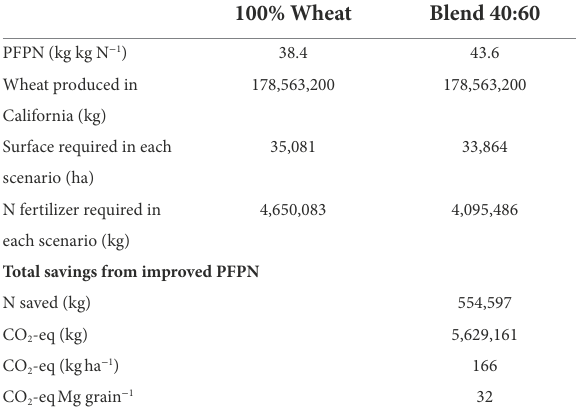
TABLE 4 Differences between production scenarios comparing 100% wheat and 40:60 blending (wheat:triticale) from targeted environments and its implications for fertilizer N savings and GWP expressed in CO 2 -eq based on differences in improved